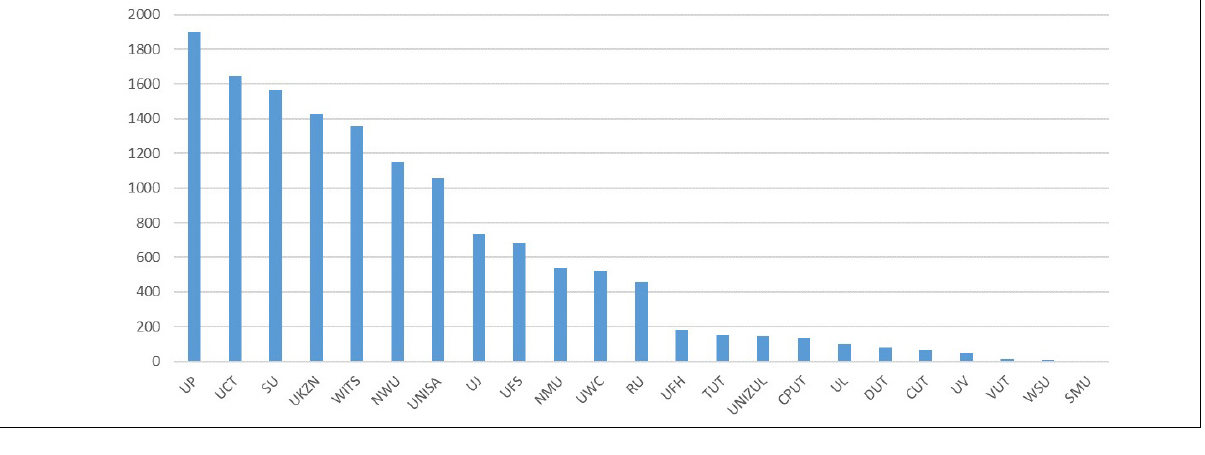
Figure 1: Number of graduates listed in the South African Theses Database per